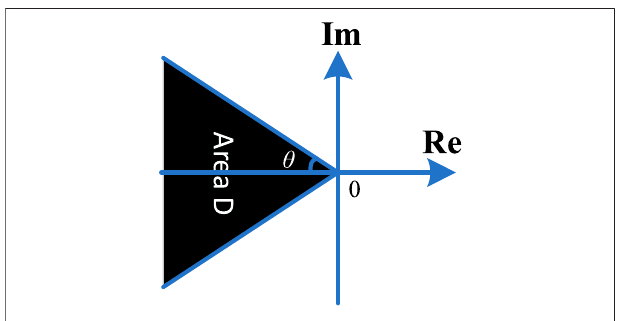
FIGURE 6 | Robust control diagram for the LFO damping control.